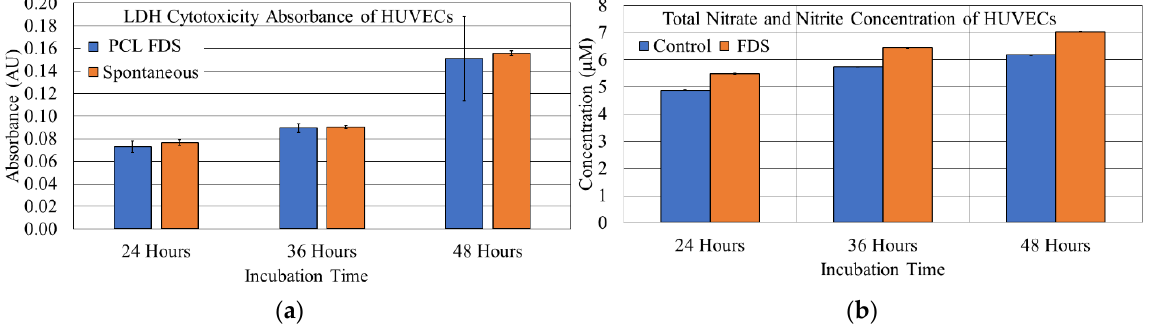
Figure 7. Quantification of ( a ) LDH release with LDH Cytotoxicity Assay with ± 1 standard error bars and ( b ) Nitrate/Nitrite Concentration with ± 1 standard error bars from HUVECs seeded with PCL FDS and well plate as the control for 24, 36, and 48 h of incubation period.